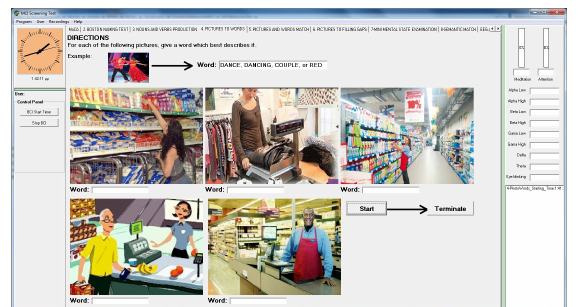
Fig. 1. Screenshoot of the ‘Naming Actions’ test Fig. 2. Screenshoot of the ‘Pictures to Sentences’